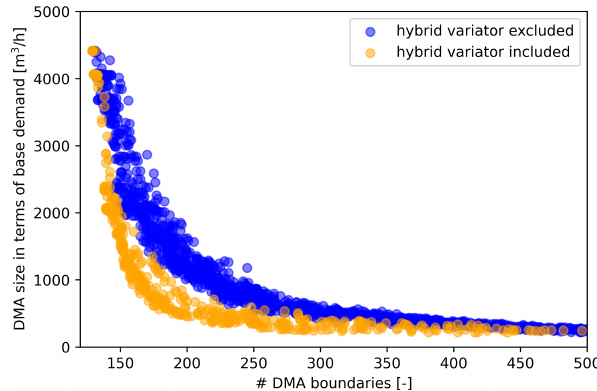
Figure 14. The results of the experiments, which are summarized as the hypervolumes produced and plotted against the computation time (each experiment was performed in